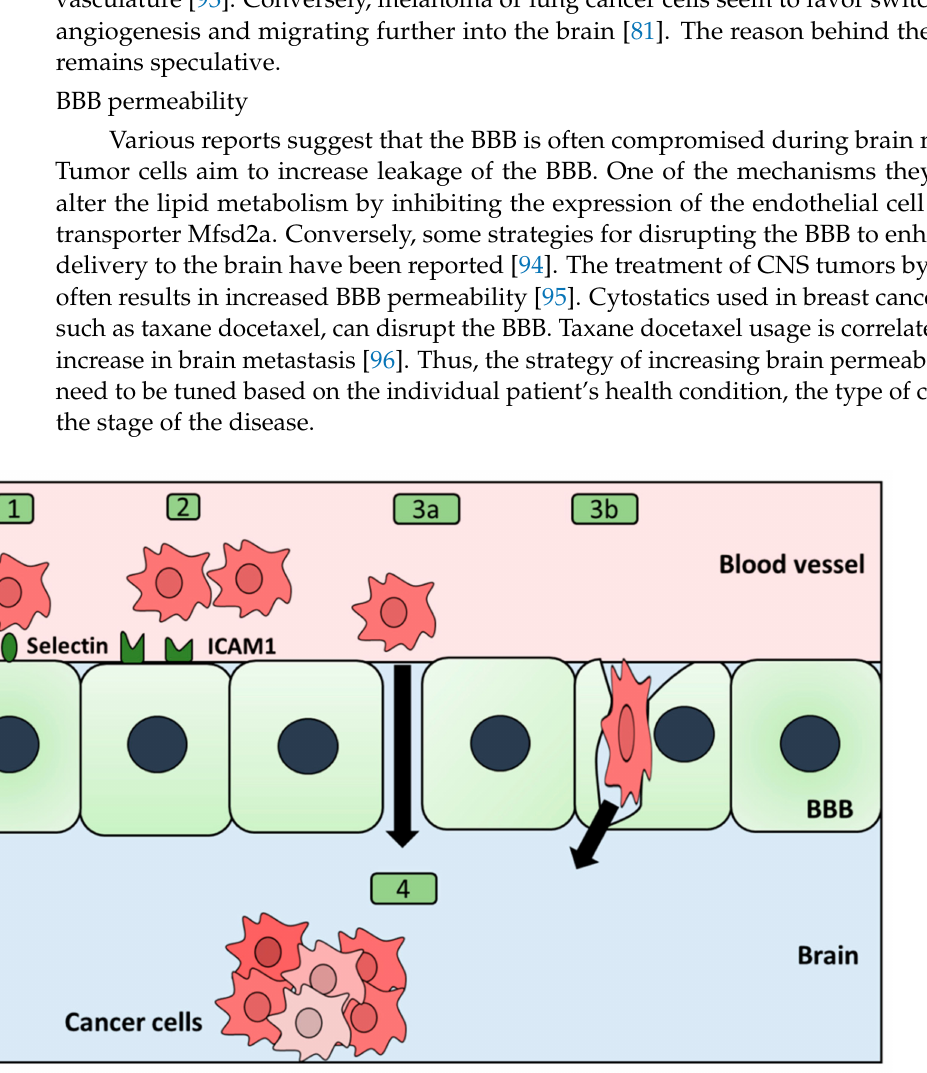
Figure 3. Cancer cells infiltrating the blood–brain barrier. The infiltration process comprises three primary phases: (1) rolling, (2) adhesion, and (3a) transmigration. Transmigration can take a paracel- lular route (between the cells) or (3b) transcellular route (through the cell). (4) After infiltration of the BBB, cancer cells choose either to colonize the areas proximal to endothelial cells or to migrate further into the